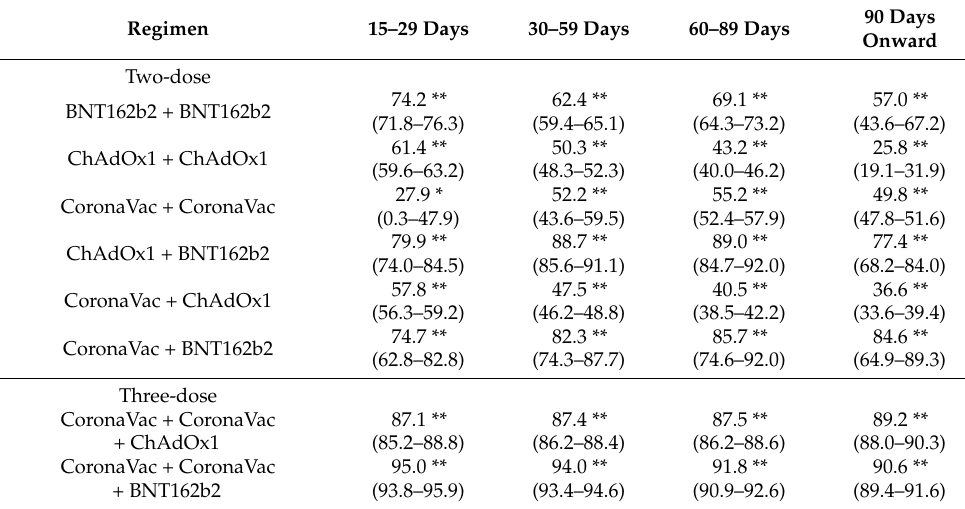
Table 3. Vaccine effectiveness against any infection for two-dose and three-dose vaccine regimens sorted by time since last vaccination.